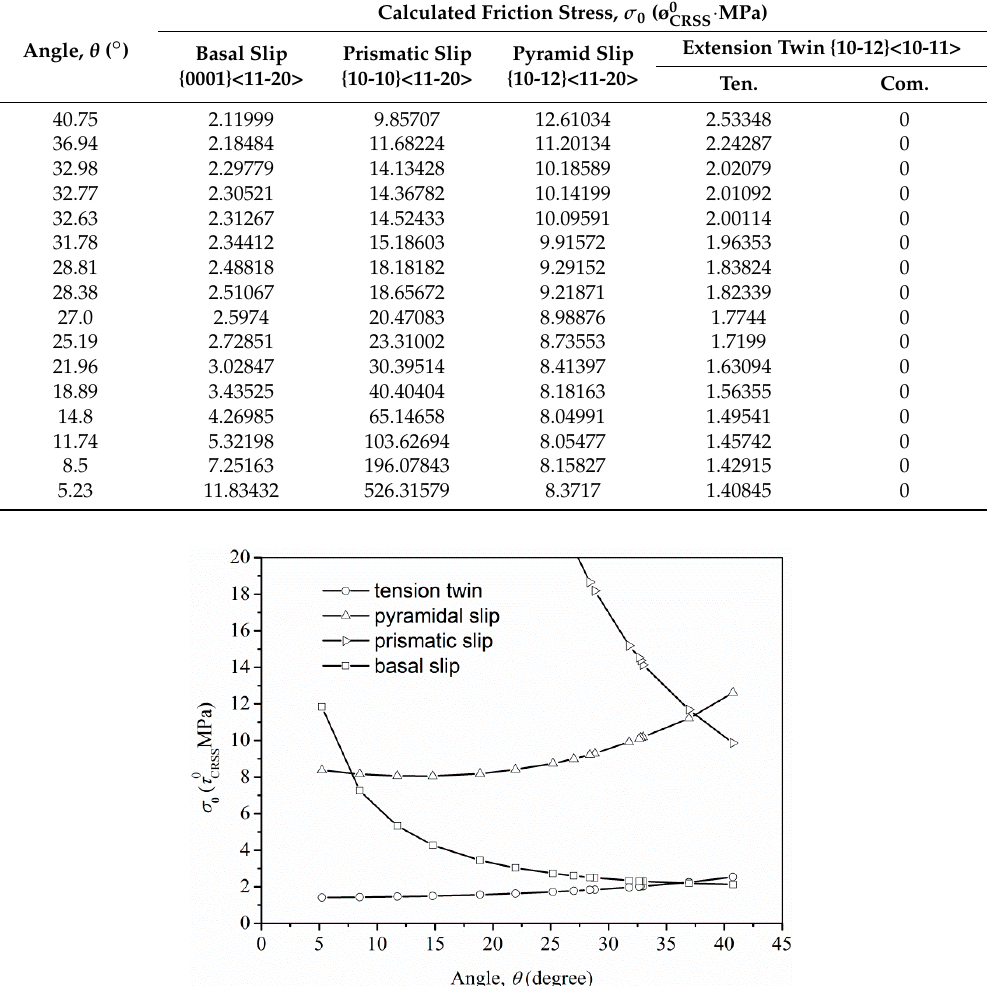
Table 4. Calculated friction stress, σ 0 , for different deformation modes as a function of the angle, θ , between the c-axes of the grains and the ED based on Table 3.